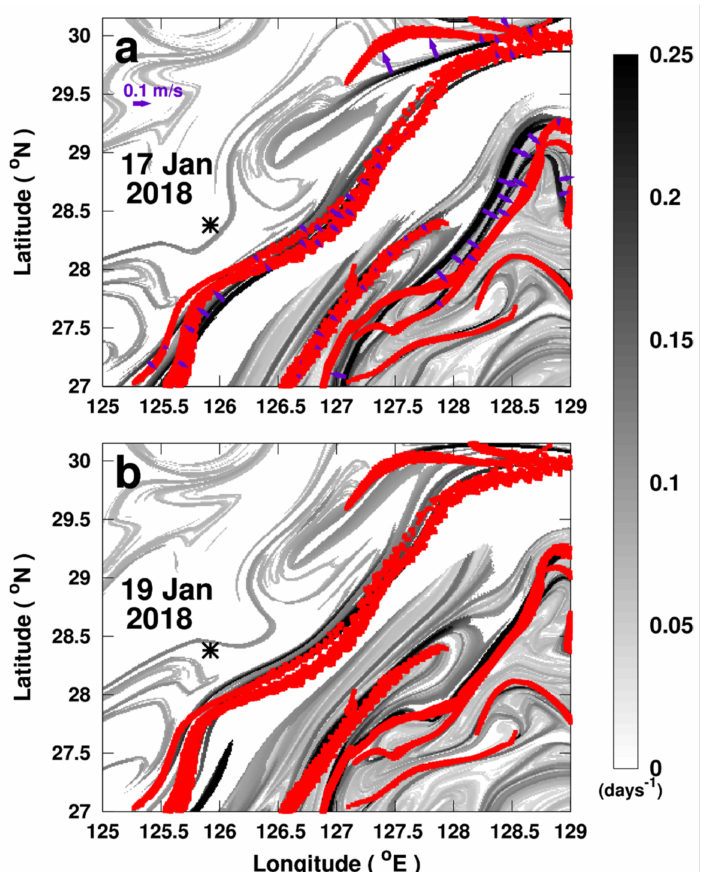
Figure 13. Comparison of the placement of the predicted fronts by the prediction method to the positions of the real ones derived from the FSLE computation. The red filaments correspond to the new position of the fronts of the 17th of January 2018 ( λ > 0.18 days − 1 ) after a 2-day prediction application. The gray-scaled fronts in the background of panels ( a , b ) are the Lagrangian fronts derived from the FSLE for the 17th and 19th of January 2018, respectively. Panel ( a ) highlights the drifting for the 17th of January after a 2-day prediction. The purple arrows in ( a ) are the front drifting speed. Panel ( b ) allows a comparison between the experimentally-predicted fronts since the 17th of January 2018 (red filaments) and those computed by the FSLE once the required daily velocity fields were available (gray-scaled filaments). The black asterisk indicates the location where the Sanchi tanker sank, engendering the oil